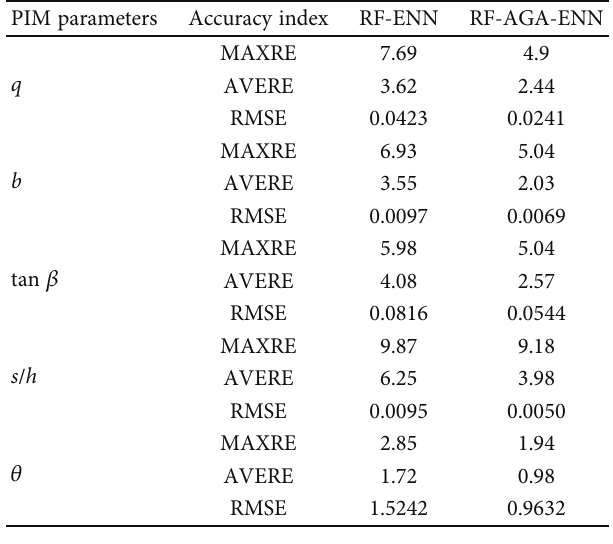
Table 4: Prediction result accuracy index values. PIM